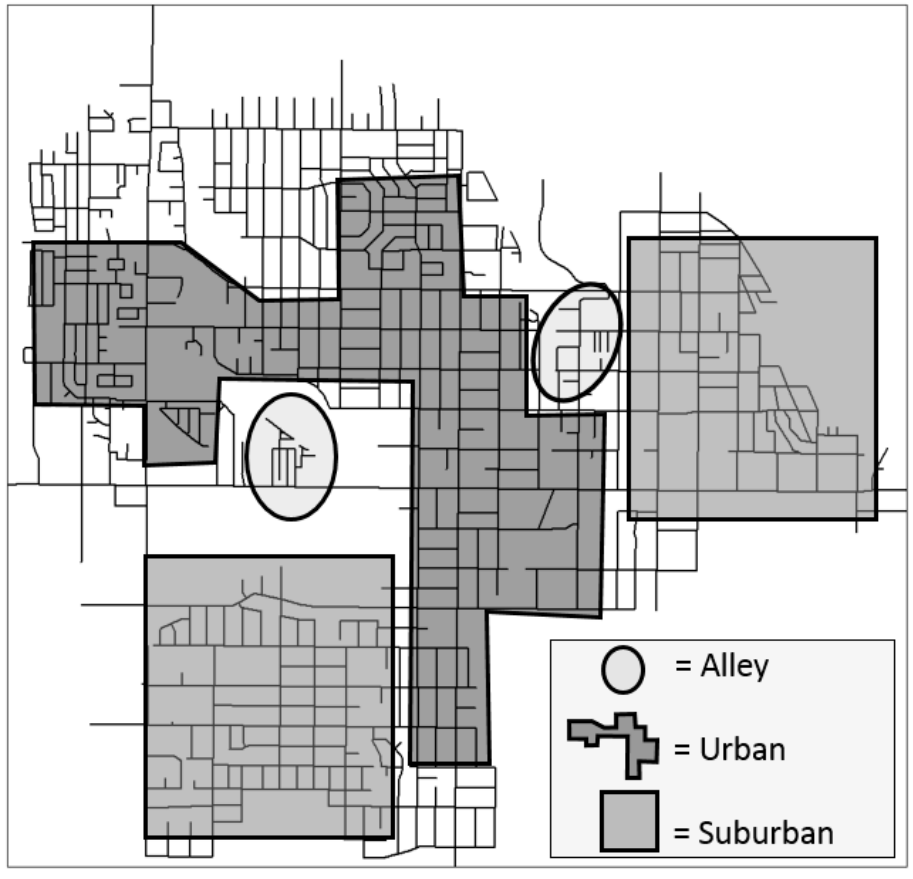
Figure 3. Study area map of branches from decision tree.